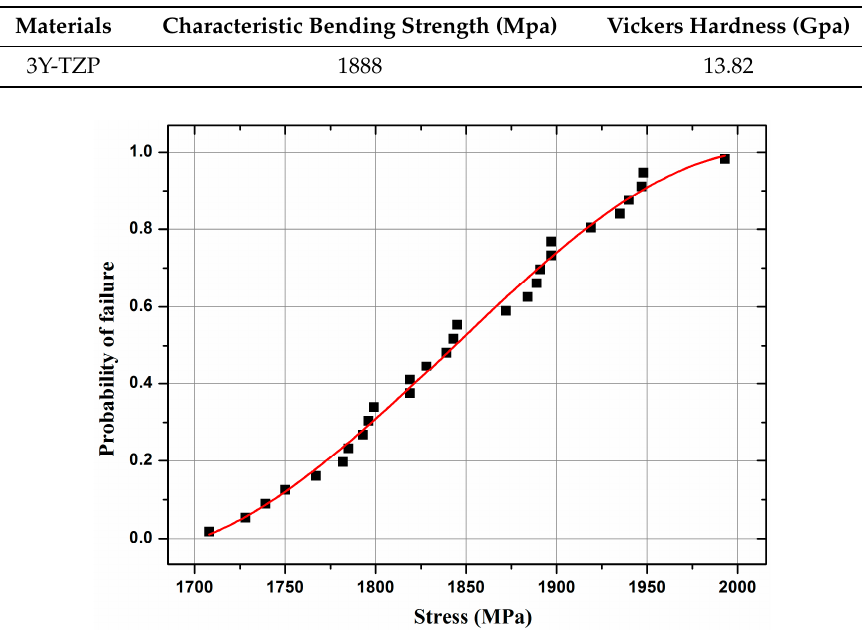
Figure 10. 3Y-TZP failure probability as a function of the applied stress. Table 1. Mechanical properties of 3Y-TZP transparent ceramics.